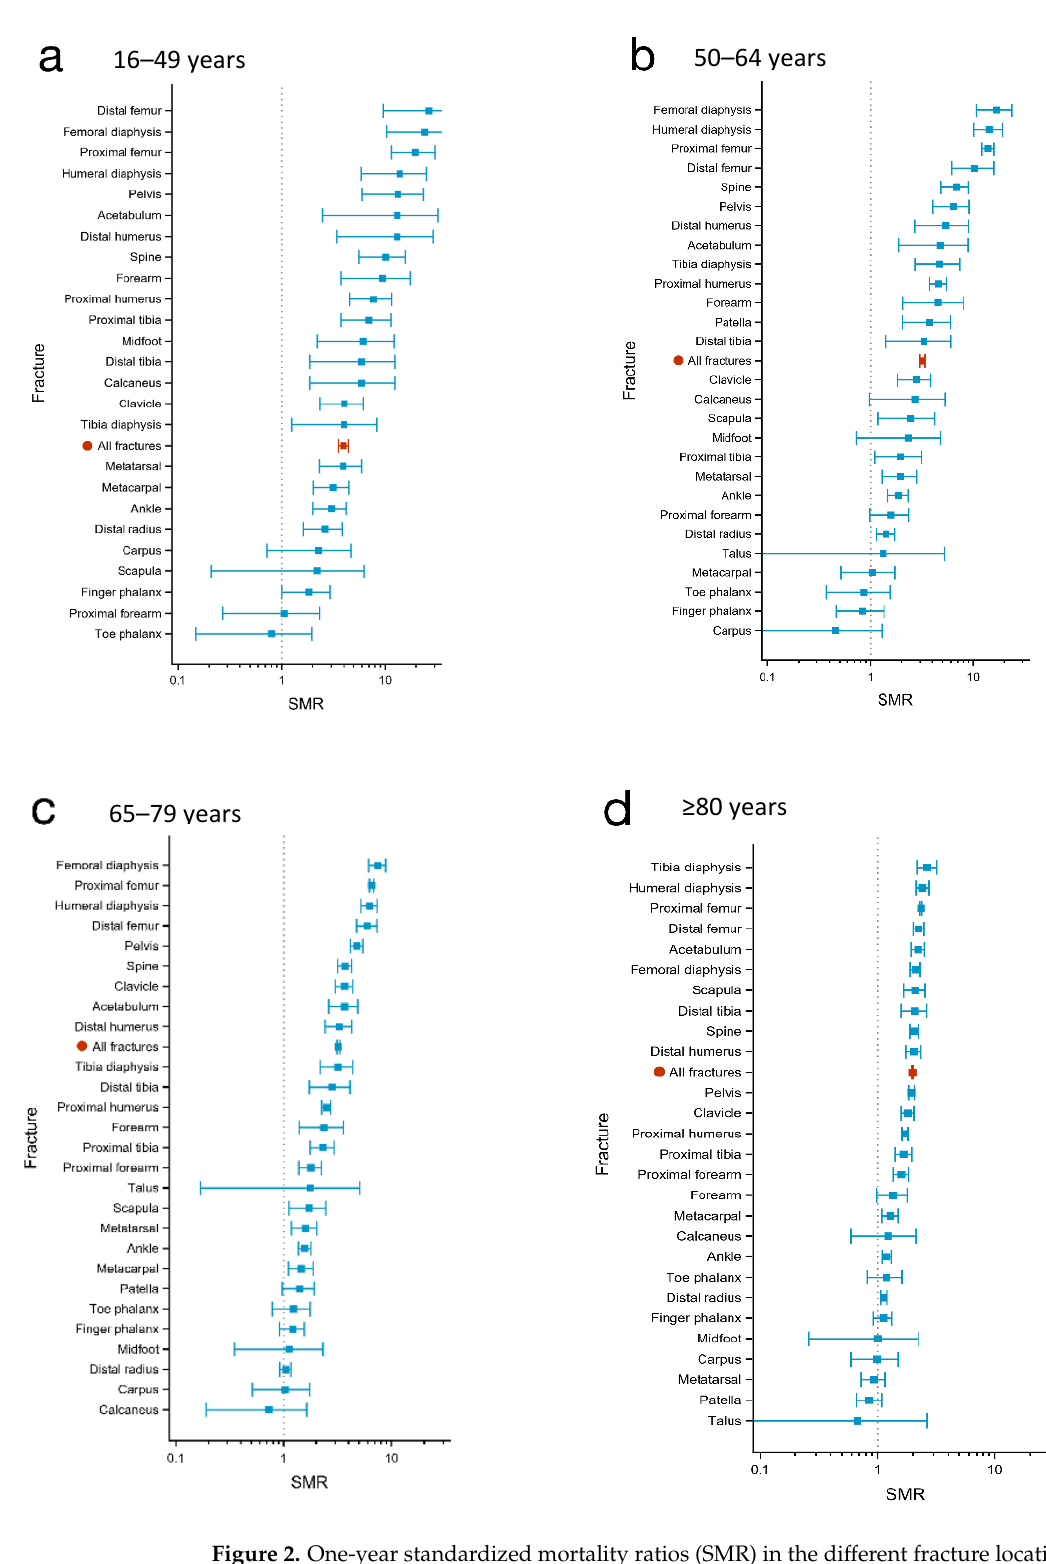
Figure 2. One-year standardized mortality ratios (SMR) in the different fracture locations in four age groups; ( a ): 16–49 years; ( b ): 50–64 years; ( c ): 65–79 years; and ( d ): ≥ 80 years. The points represent SMR and the horizontal lines represent the 95% confidence intervals.